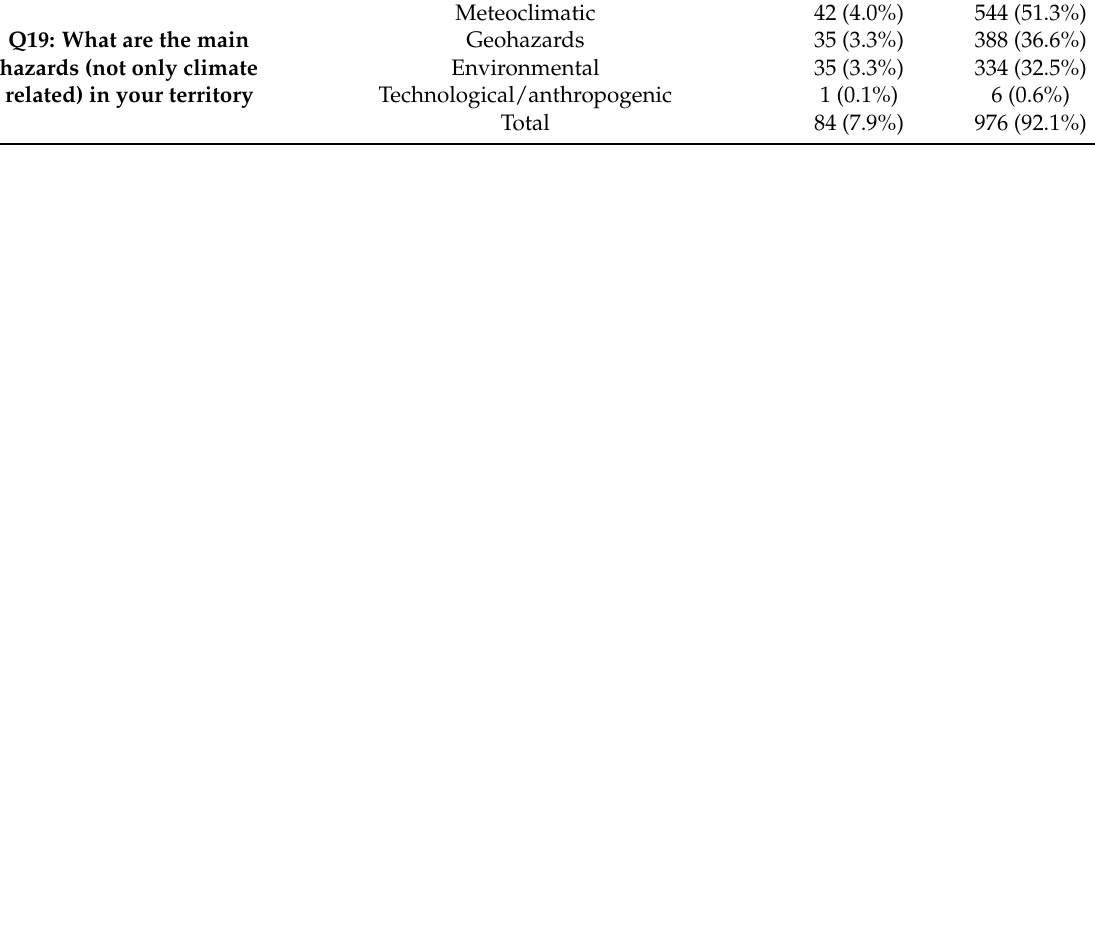
Q33: How Long Have You Lived There? ≤ 20 Years ≤ 20 Years ≤ 20